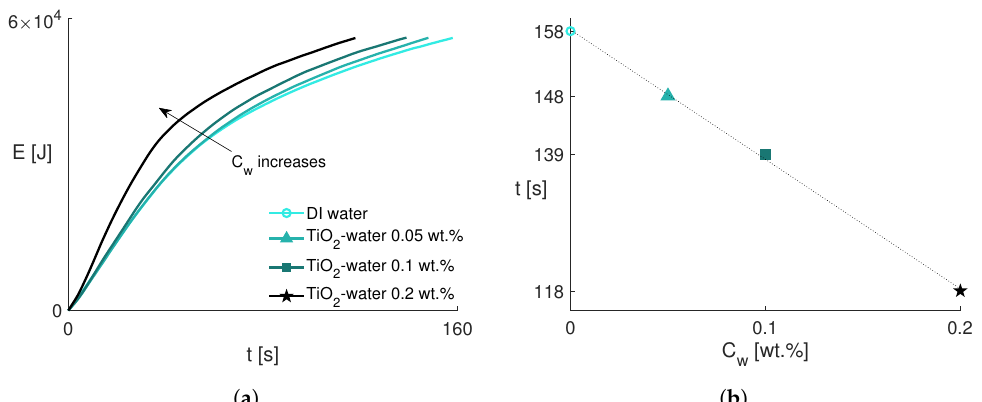
Figure 7. ( a ) Energy removed from the aluminum block as a function of time. ( b ) Elapsed time to extract the same energy from the aluminum block to cool it down from 190 to 65 ◦ C as a function of nanofluid concentration. The same legend applies to both